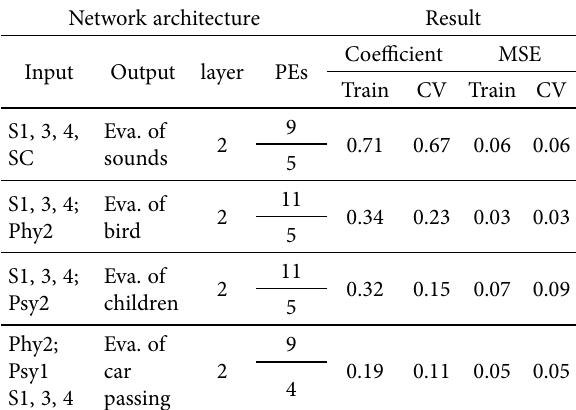
Table 2. JdP – Individual models for predicting